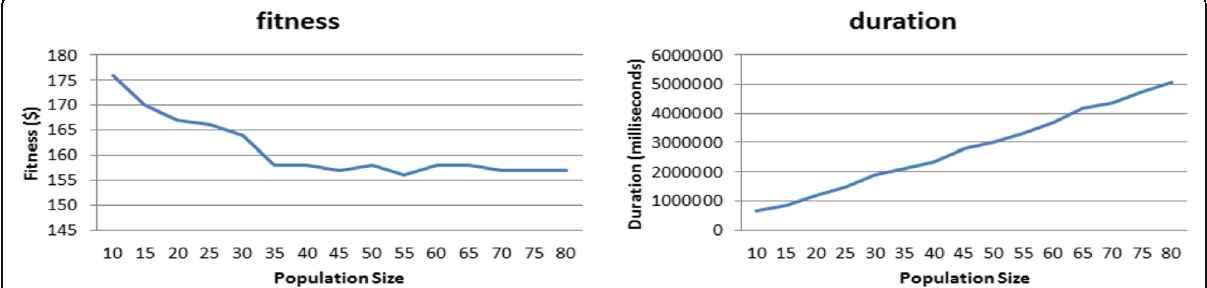
Fig. 5 The population size effect on the experiment duration and the fitness